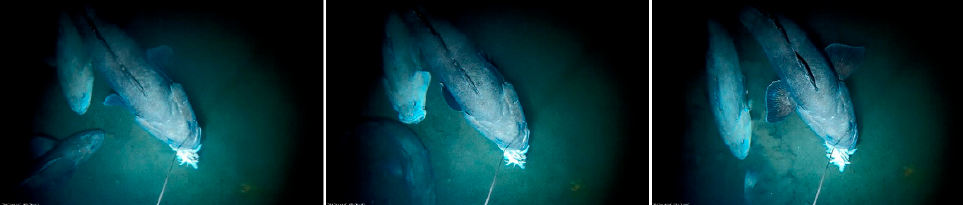
Figure 5. Sequence of an agonistic event. Two toothfish are involved (left side of the images) on the side of a third individual which is eating the bait. Video recorded at Site 06, Terra Nova Bay.